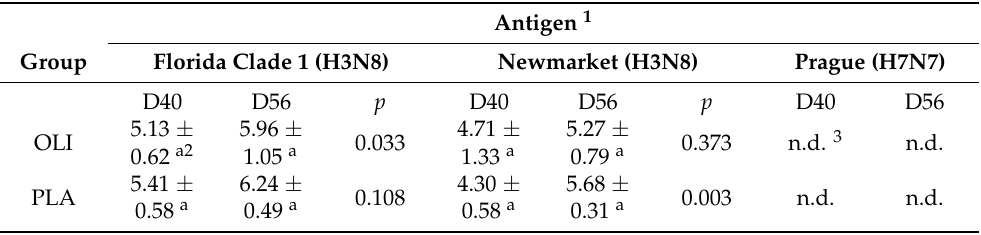
Table 4. ELISA titer of Influenza-specific antibodies.